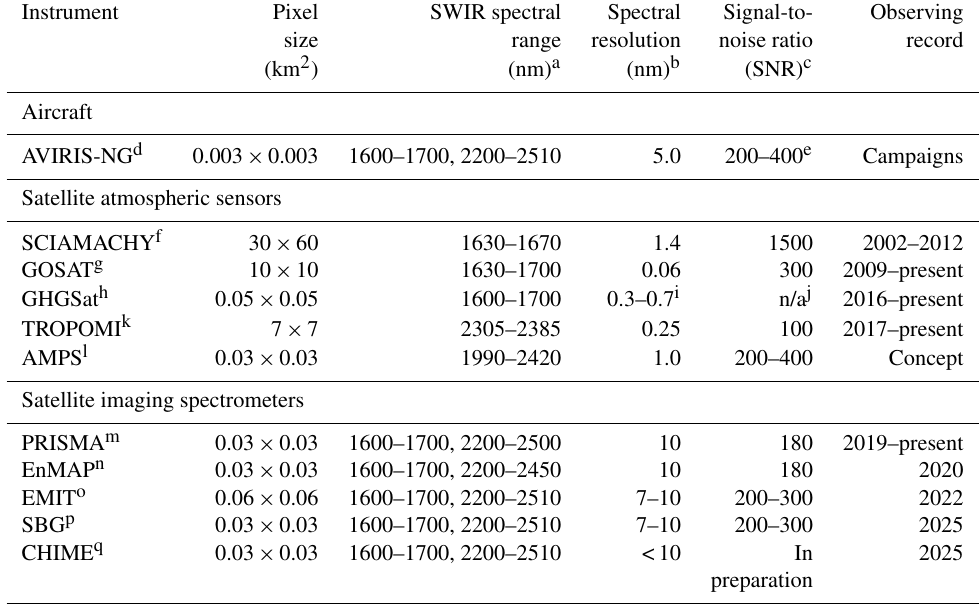
Table 1. Shortwave infrared (SWIR) remote sensors for observing methane point sources.